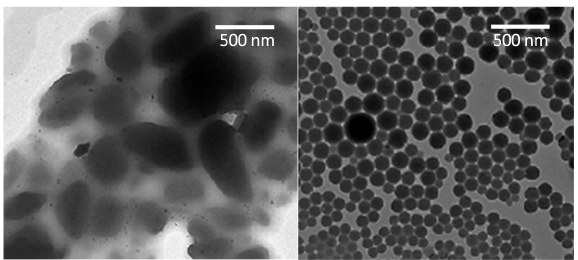
Figure 1. TEM figure of itraconazole nanocrystals produced by nanomilling with poloxamer F 68 as a stabilizer ( left ) and antisolvent precipitation with hydrophobin as a stabilizer ( right ). The compositions and process parameters can be found from the references [7,18], reprinted with permission).